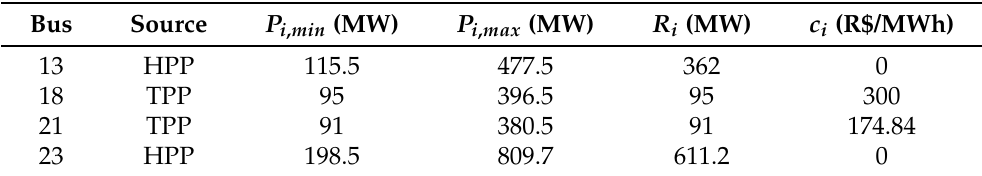
Table 3. Characteristics of the Thermoelectric Power Plant (TPP) and the Hydroelectric Power Plant (HPP). Data source: [27].